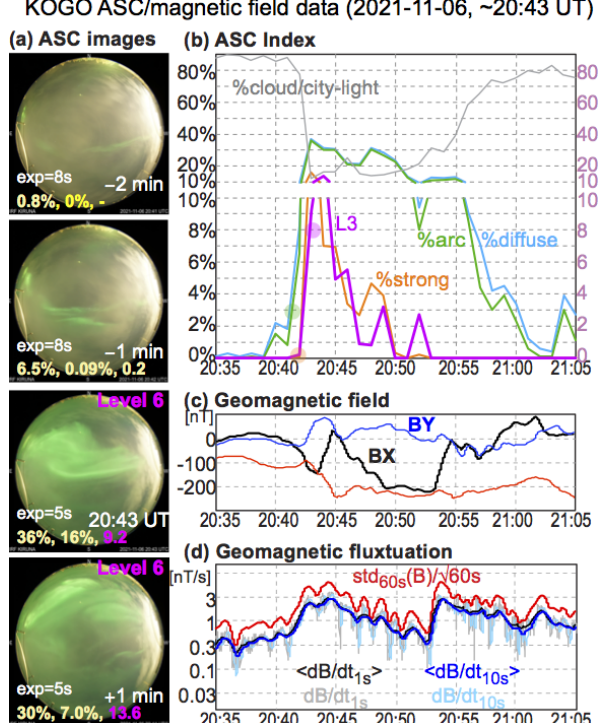
Figure 8. The ASC images, ASC auroral index values, and geomag- netic data from around the time when the Level 6 auroral activity was detected at 20:43UT on the same night as in Fig. 7. The format is the same as in Fig. 7 except that the cloud coverage is not shown in the ASC images.